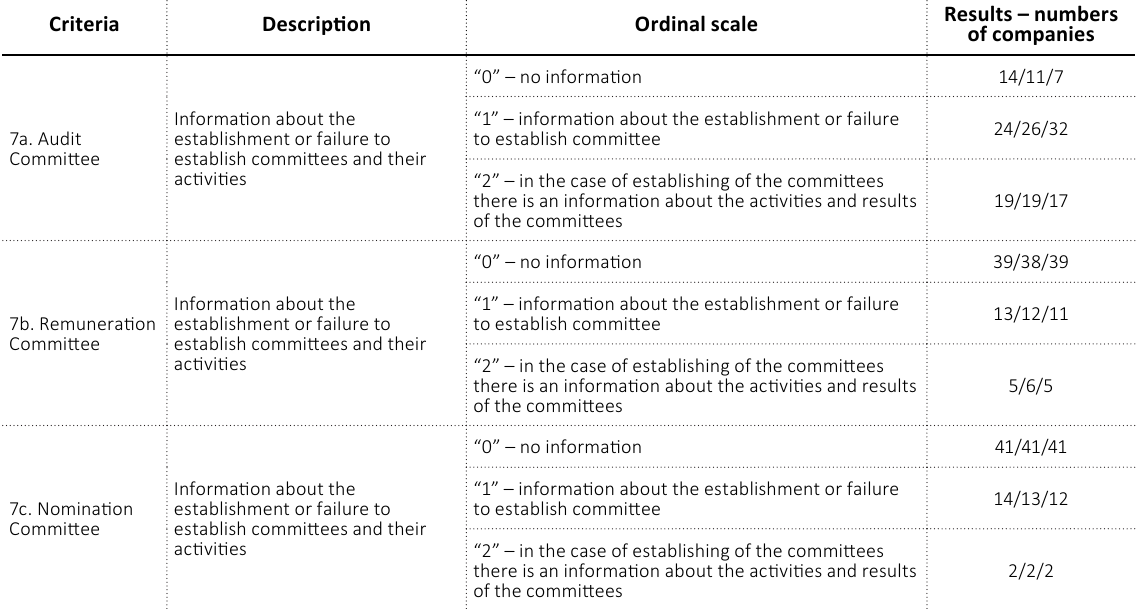
Table C1. Evaluation of the 7th (7a, 7b, 7c) criteria and